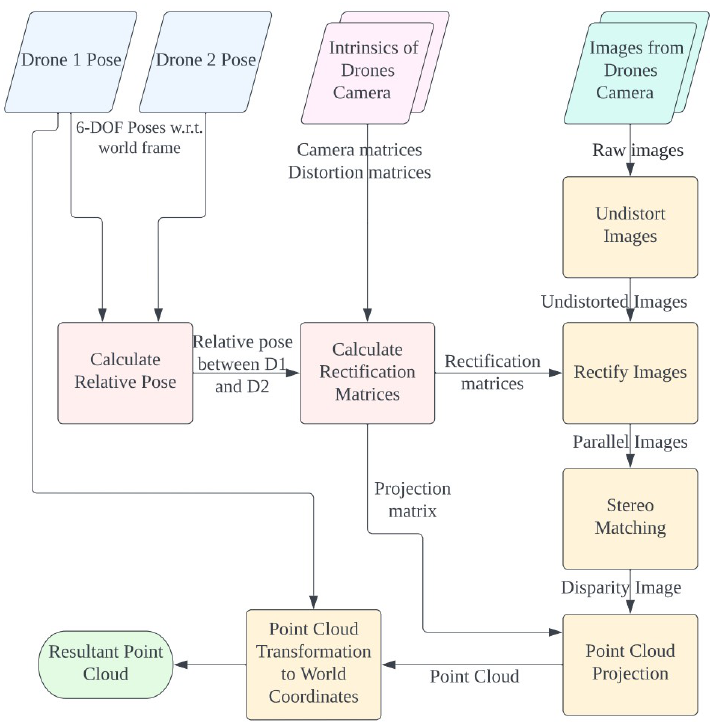
Figure 7. Flowchart of the process in image processing along with data used to process from raw images to 3D point cloud.